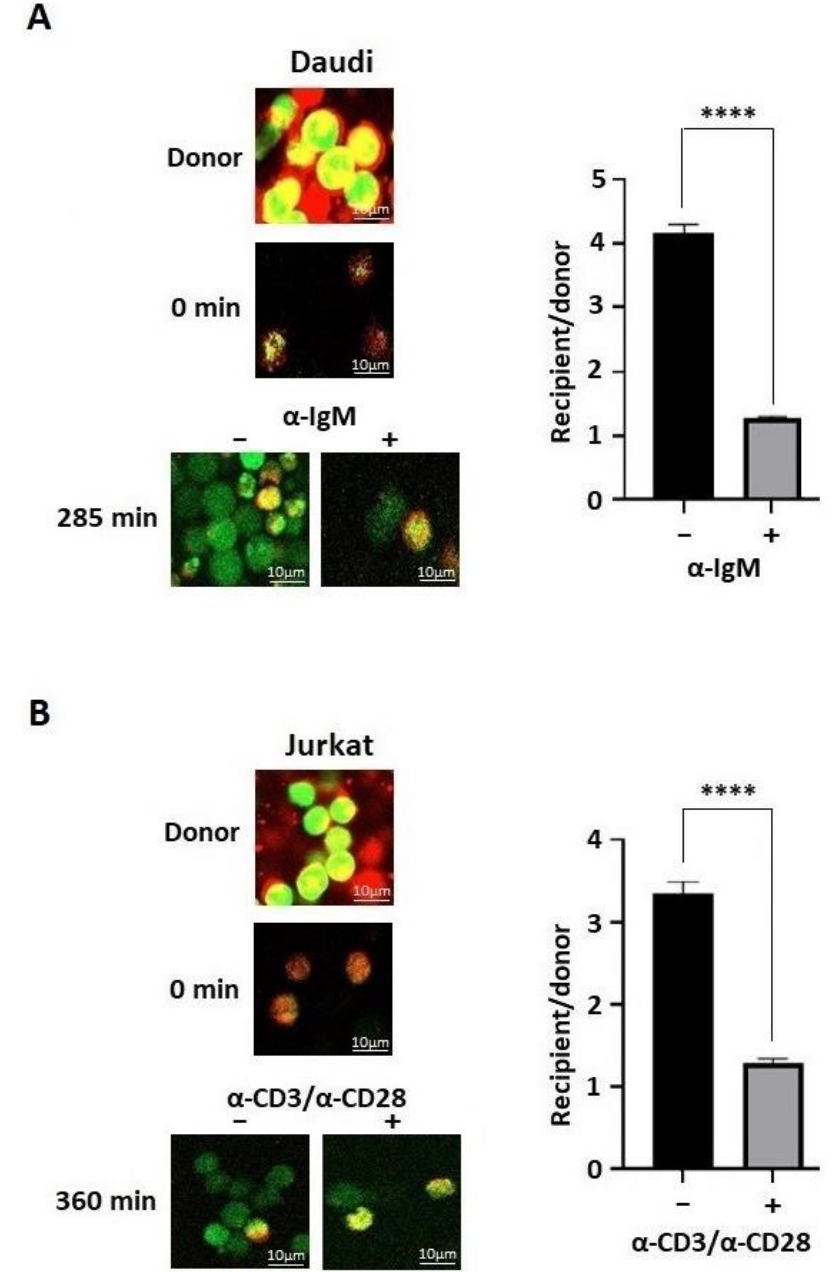
Figure 9. The effect of BTK and ITK phosphorylation on the Cx43 gap junction intercellular com- munication in lymphocytes. A parachute dye coupling assay was used to assess communication from the ( A ) Daudi cells with and without BTK activation using the α -IgM antibody or ( B ) Jurkat cells with and without ITK activation using the α -CD3/ α -CD28 antibodies. Representative confocal images (Red, Dil; Green, calcein; Yellow, donor cells) are provided. Quantification was conducted by GraphPad Prism (units represent number of cells). Data represent the Student’s t -test ( n = 3, **** p < 0.0001).